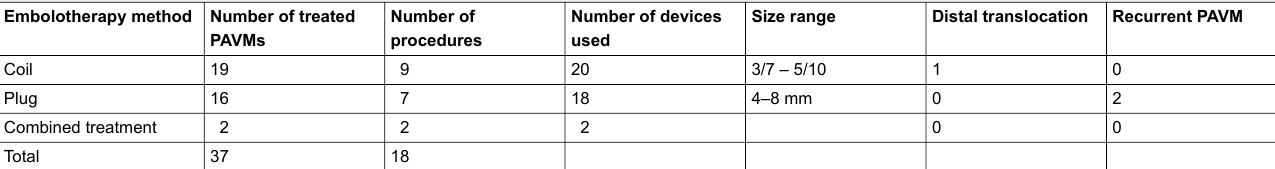
Table 2: Results of embolotherapy by method. Recurrent pulmonary ateriovenous malformations (PAVMs) occurred in patients treated with vascular plugs at 10 days and 3 months. Embolotherapy method Number of treated